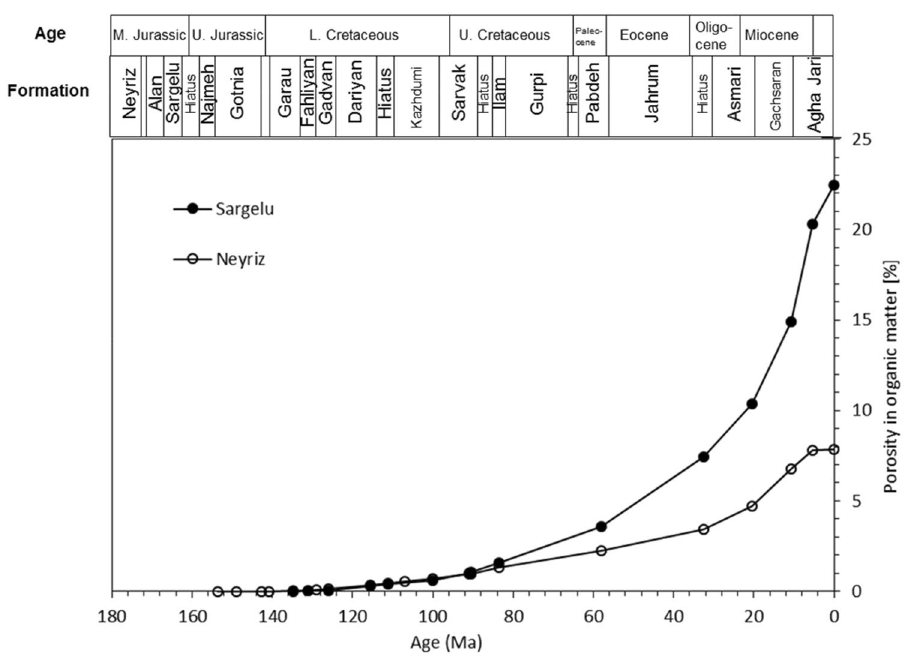
Fig. 16 Computed organic porosity of organic matter through geological time for initial TOC of 14% and 4% for the Sargelu and Neyriz source zones in Well